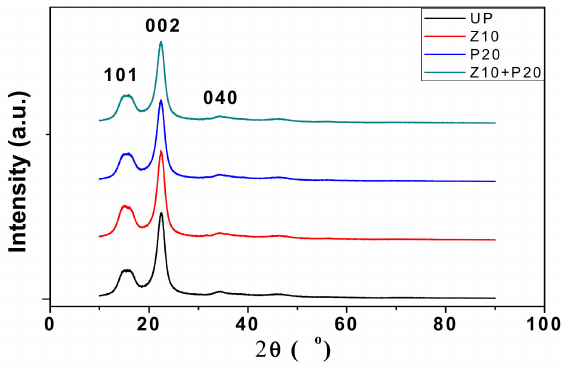
Figure 9. The results of small-angle X-ray di ff